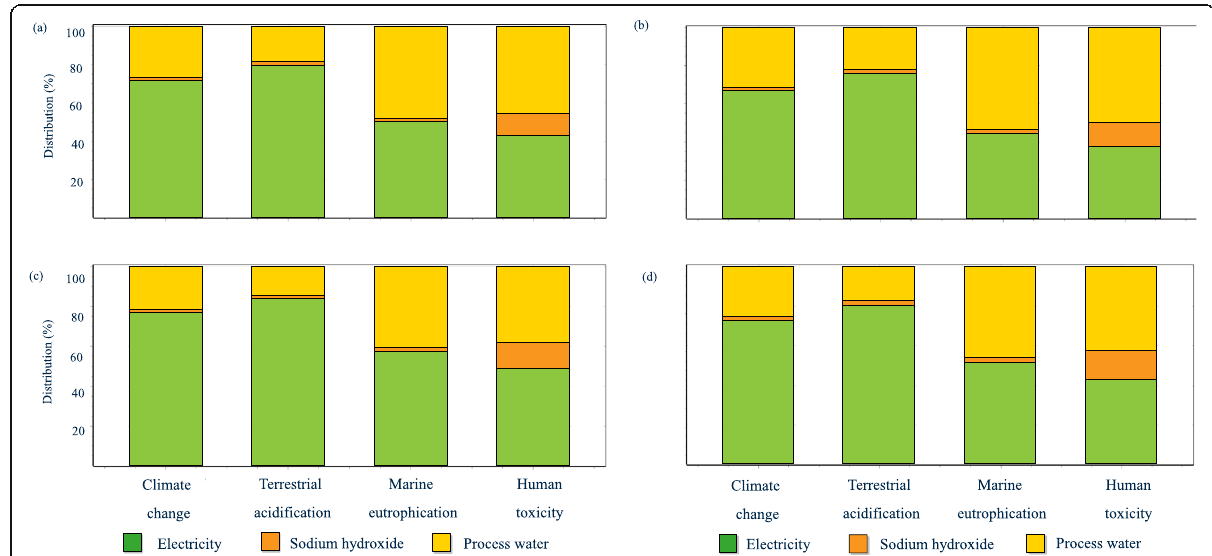
Fig. 3 Distribution of life cycle impact categories contributed by a Combination I of integrated membrane-filtration system, b Combination II of integrated membrane-filtration system, c Combination III of integrated membrane-filtration system, d Combination IV of integrated membrane-filtration